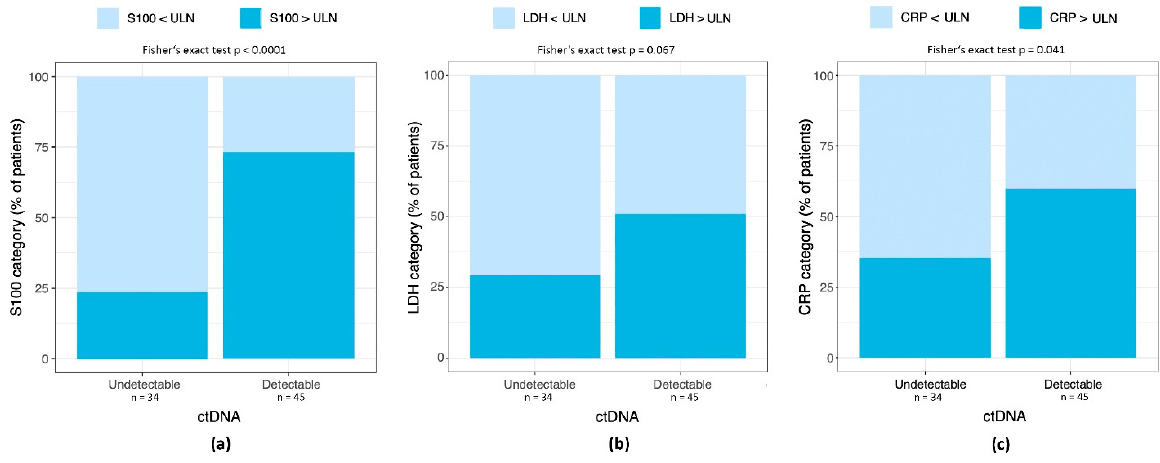
Figure 3. ( a ) Percentage of patients with S100 > ULN in patients with detectable and undetectable ctDNA. ( b ) Percentage of patients with LDH > ULN in patients with detectable and undetectable ctDNA. ( c ) Percentage of patients with CRP > ULN in patients with detectable and undetectable